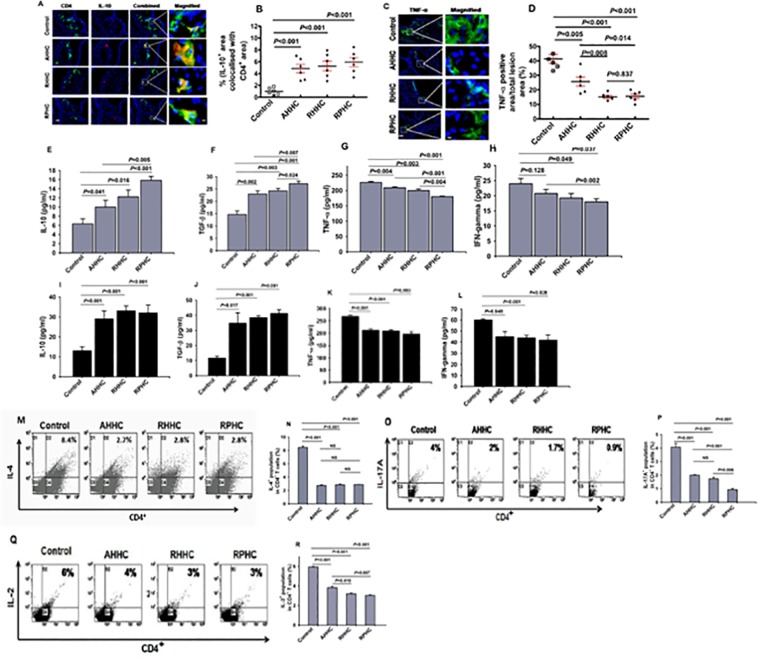
Assessment of IL-10-producing T cells, TNF-α expression in the lesions and cytokine levels in B6;129S-Ldlr
tm1Her
Apob
tm2Sgy
/J mice fed a high-fat diet after immunization with constructs AHHC, RHHC, and RPHC.(A) Photomicrographs showing dual-IHC staining for IL-10 (red) and CD4 (green) (scale bar: 100 μm and 12.5μm for magnified ones). (B) Scatter plot showing mean of IL-10-positive area co-localized with CD4+ area (%) (N = 6). (C) Photomicrographs showing IHC staining for TNF-α (green) of lesions (scale bar: 100 μm and 12.5μm for magnified ones). (D) Scatter plot showing mean of anti- TNF-α-stained area in the lesion versus total lesion area (N = 6). (E-H) Cytokine levels measured in plasma. (I-L) Cytokine levels measured in the supernatant of splenocytes stimulated with ConA. (M) Representative analysis of CD4+IL-4+ T-cells in splenocytes from construct-immunized mice fed on a high-fat diet as assessed by flow cytometer. (N) Percentages of IL-4+ expressing CD4+ spleen cells. Data are expressed as mean of 3 analyses ± SEM. Differences between groups are shown. (O) Representative analysis of IL-17A expression by CD4+ T-cells in splenocytes from construct-immunized mice fed on a high-fat diet as assessed by flow cytometry. (P) Levels of IL-17A expression in spleen cells. Data are expressed as mean of 3 analyses ± SEM. Differences between groups are shown. (Q) Representative analysis of CD4+IL-2+ T-cells in splenocytes from construct-immunized mice fed on a high-fat diet as assessed by flow cytometer. (R) Levels of IL-2+ expressing CD4+ in spleen cells. Data are expressed as mean of 3 analyses ± SEM. Differences between groups are shown.